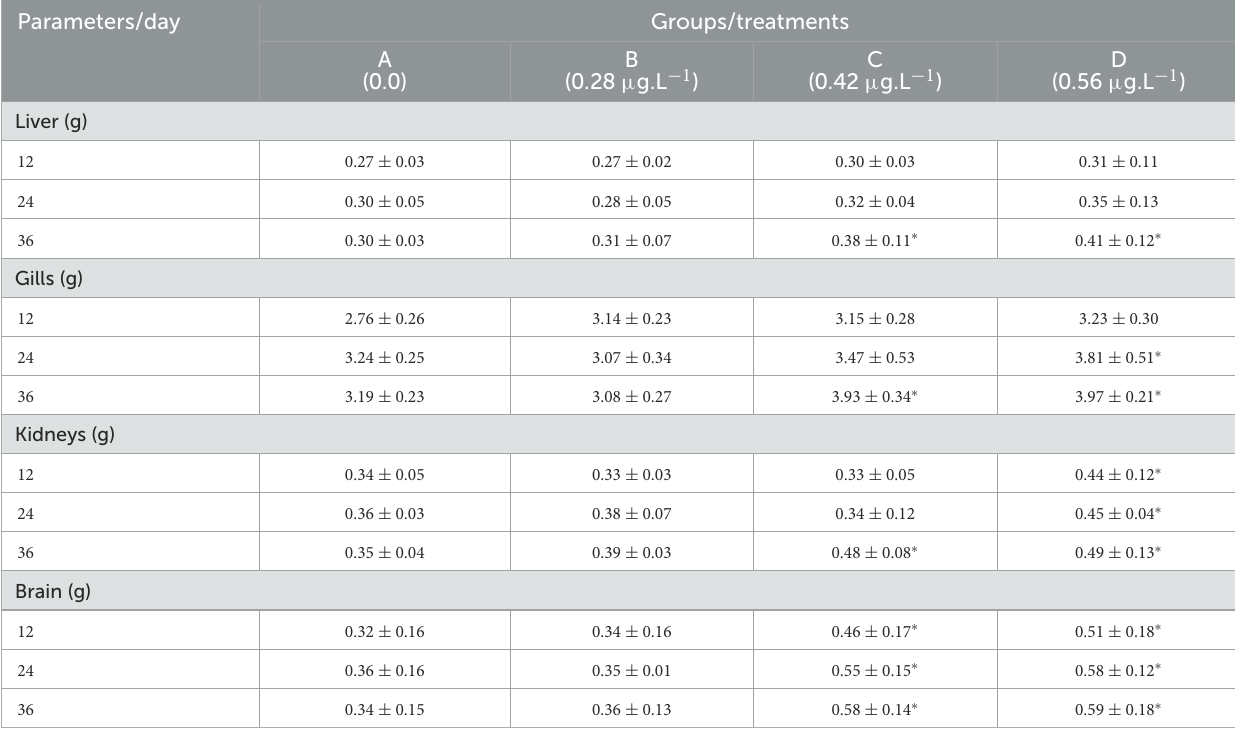
TABLE 3 Relative weight of visceral organs of Labeo rohita treated with various concentrations of copper sulfate.